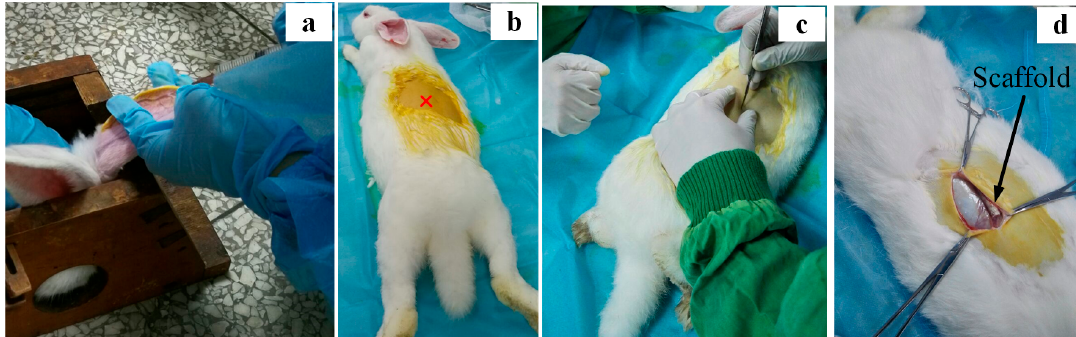
Figure 2. Pre-surgical operations of New Zealand rabbits. ( a ) Surgical operation under general anesthesia by a lateral ear vein injection; ( b ) implantation location; ( c ) start of surgery operation to open skin; and ( d ) subcutaneous socket with implantation of scaffolds.